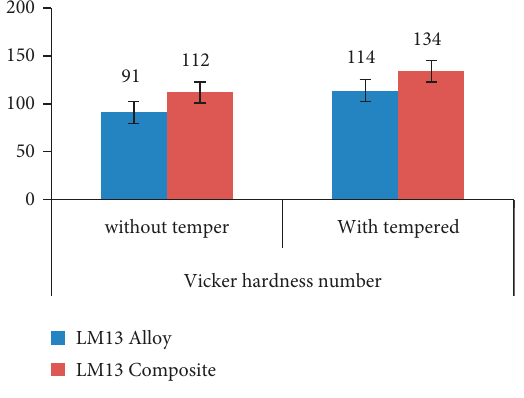
Figure 4: Hardness of the test samples.